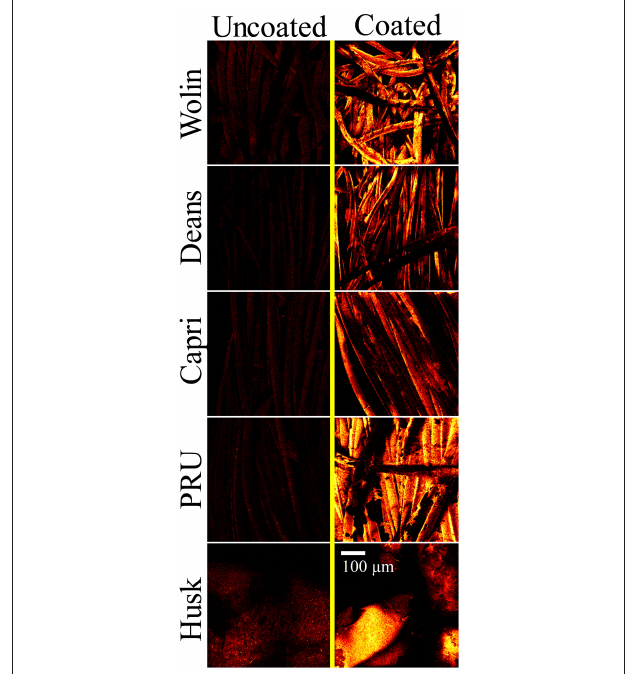
FIGURE 5 | ToF-SIMS images of C 2 H 3 O − 2 ions representative of the SbQ-PVA coating acquired for the uncoated (left) and coated (right) Vescom materials with SbQ-PVA/ZnTMPyP 4 +